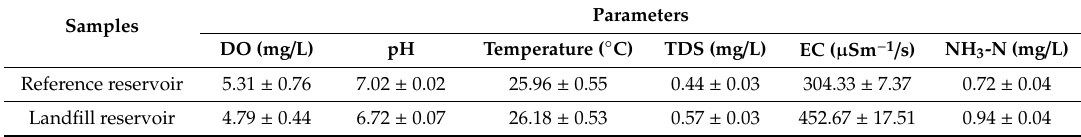
Table 3. Water quality parameters of the reference and the landfill